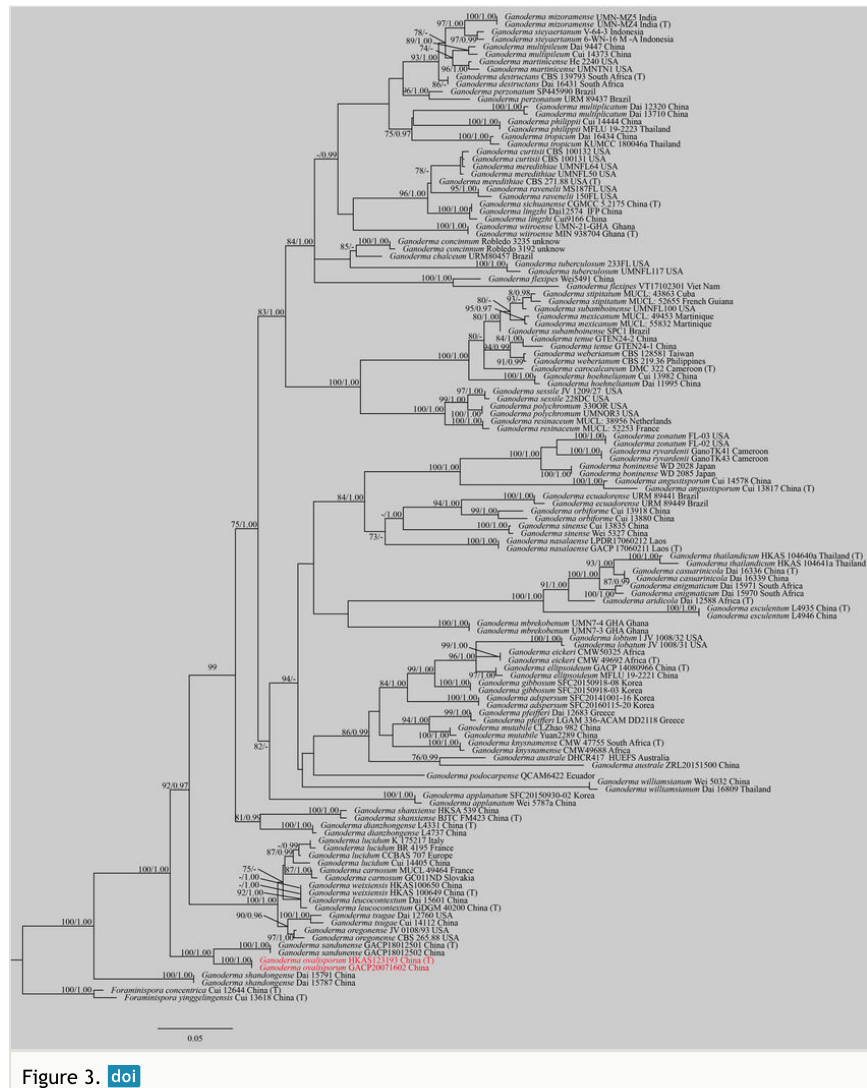
Figure 3. Phylogram for Ganoderma generated from Maximum Likelihood analysis of ITS, LSU, TEF1- α and RPB2 sequence data. Bootstrap support values for Maximum Likelihood and maximum parsimony greater than 70% and posterior probabilities of Bayesian Inference ≥ 0.95 are given above branches. Type specimens are marked with letter (T) and new species in this study are indicated in